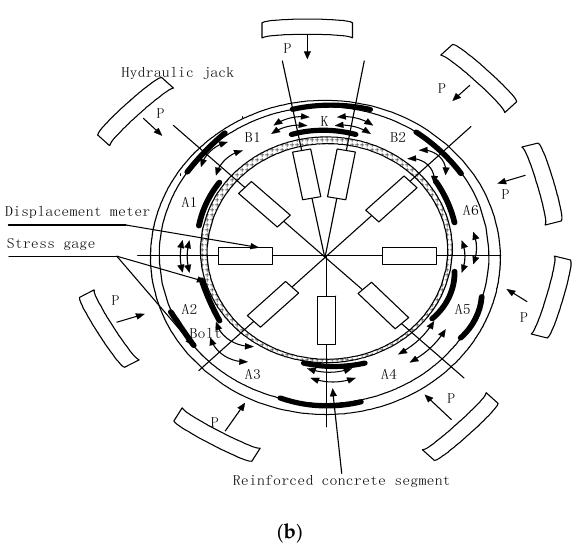
Figure 3. Accelerated loading of CFRP-strengthened tunnel segmental lining. ( a ) Test loading diagram, ( b ) schematic diagram.